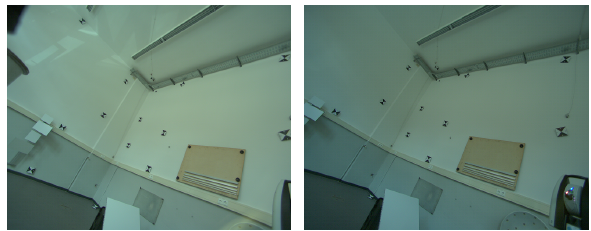
Figure 3. Images of the left camera in station 1 (left) and 2 (right).